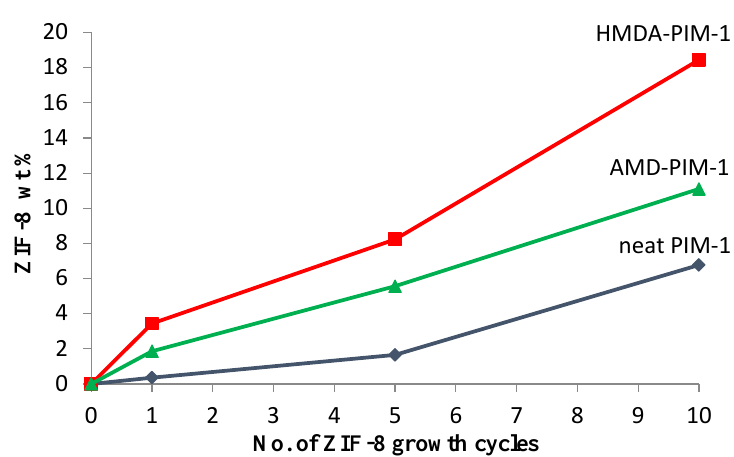
Figure 2. Amount of zeolitic imidazolate framework-8 (ZIF-8) deposited with increasing number of growth cycles on HMDA-PIM-1 ( ), AMD-PIM-1 ( ) and neat PIM-1 membranes ( ).